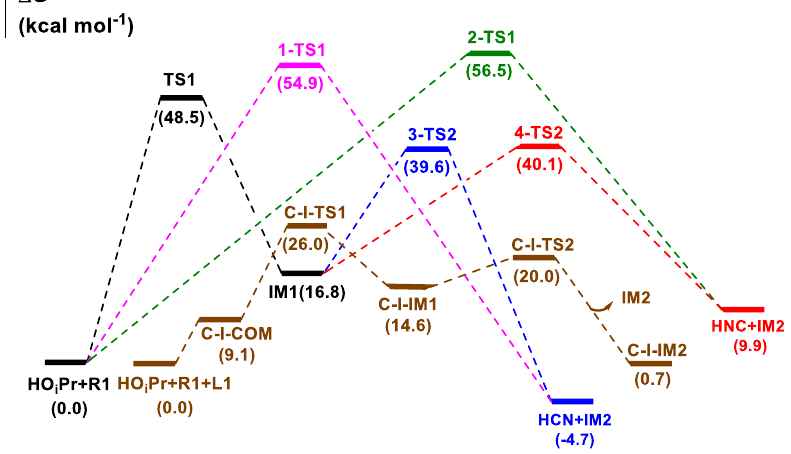
Figure 1. Potential energy profiles for the formation of HCN or HNC by the reaction between HOiPr and CNCOOEt (R1) without a catalyst and in the presence of cinchona alkaloid (L1).